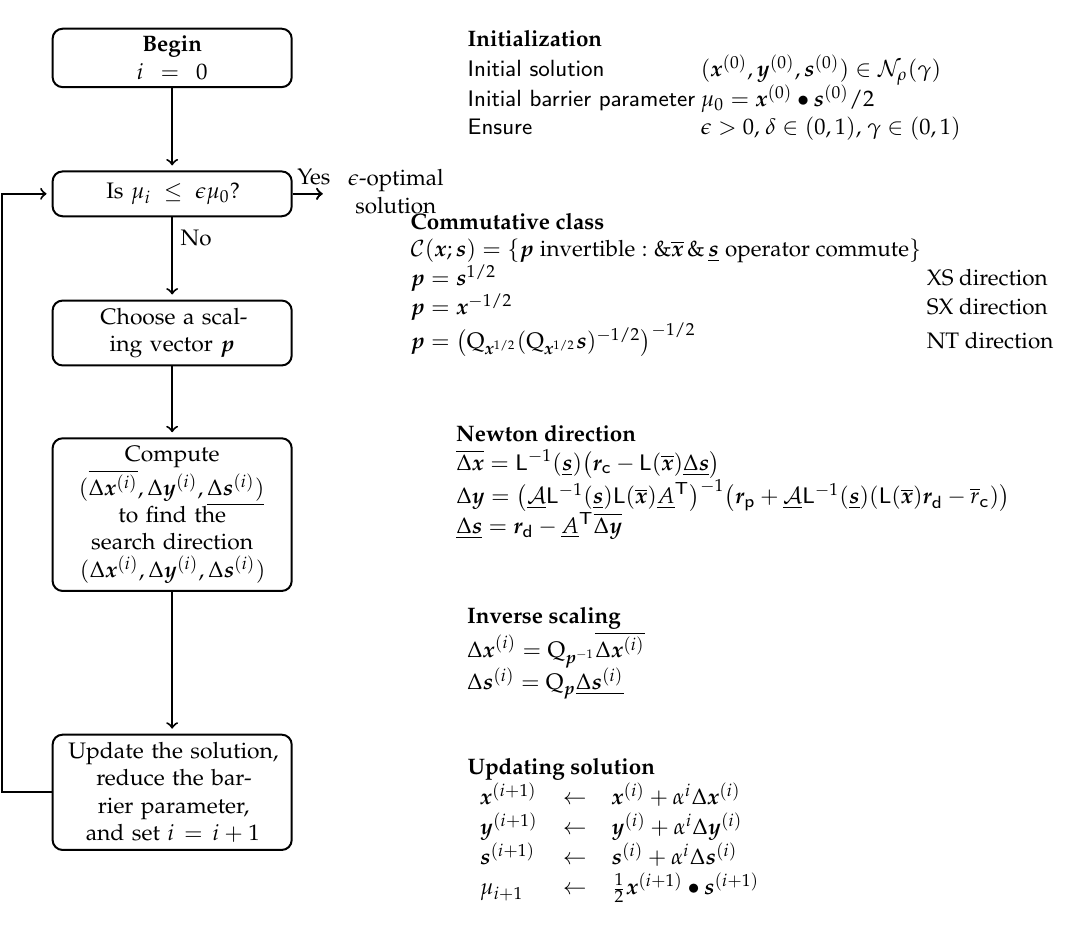
Figure 2. A pseudocode for Algorithm